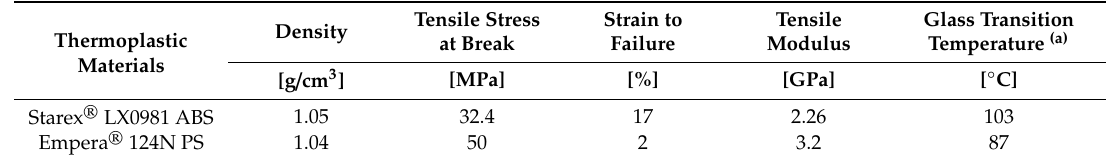
Table 3. Physical, mechanical and thermal properties of the thermoplastic interleaves (from the manufacturer’s